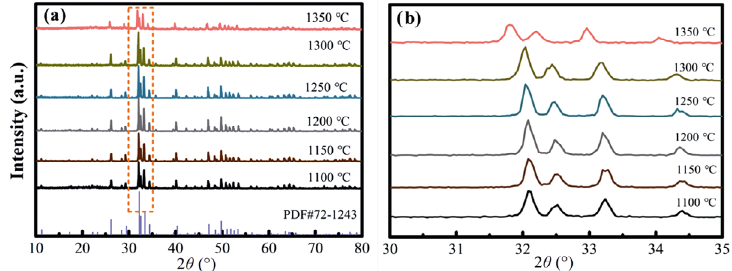
Fig. 6 (a) XRD spectra of the HA samples sintered at different temperatures and (b) partial enlargement ranges from 30° to 35°.